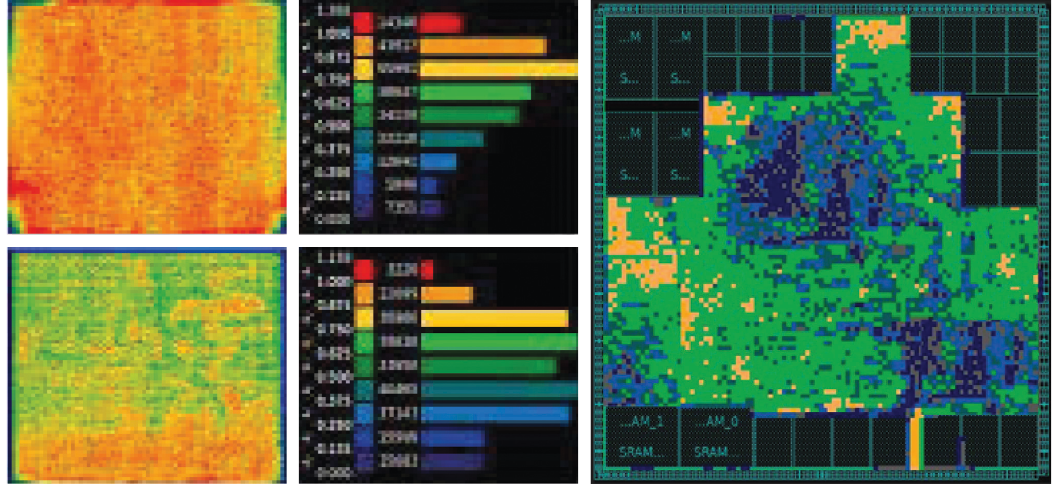
Figure 4: Congestion distribution on chip